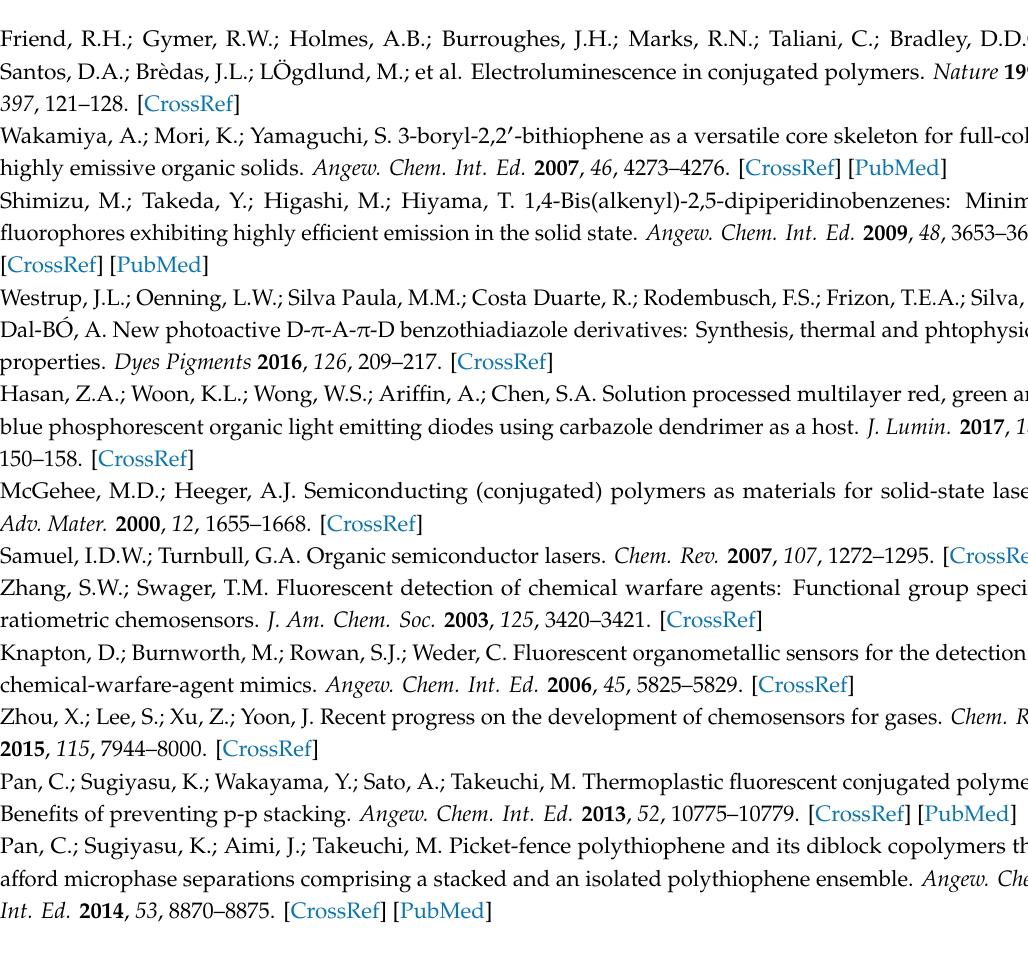
Figure S1: The absorption of solvatochromic e ff ect for BTC6 (a) and BTC0 (b); The PL spectra of solvatochromic e ff ect for BTC6 (c) and BTC0 (d). Figure S2: Transient PL decay curves of BTC0 and BTC6 in chloroform solutions (10 − 6 M) (a); Transient PL decay curves of BTC0 and BTC6 in solid state (b). Figure S3: Calculated electronic density contours and energy levels of HOMO and LUMO. Figure S4: Solution of BTC0 before electrochemical measurement (a) and after electrochemical measurement (b). Figure S5: TGA spectra of BTC0 and BTC6. Figure S6: 1 H NMR of BTC0 in CDCl 3 . Figure S7: 13 C NMR of BTC0 in CDCl 3 . Figure S8: 1 H NMR of BTC6 in CDCl 3 . Figure S9: 13 C NMR of BTC6 in CDCl 3 . Figure S10: FT-IR spectrum of BTC0. Figure S11: FT-IR spectrum of BTC6. Table S1: The absorption and PL maximum of